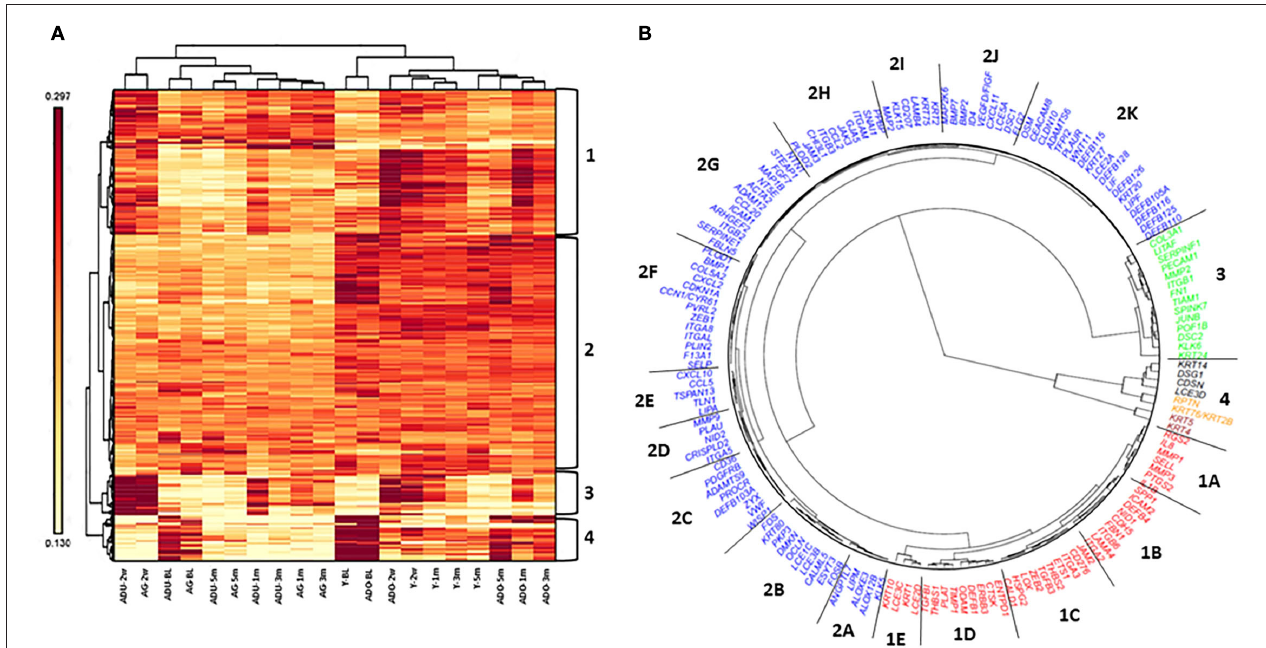
FIGURE 8 | Heatmap and cluster analysis (A) of epithelial-related genes organized by age (Y, ADO, ADU, AG) and health (BL)/disease (2w, 1m, 3m)/resolution (5m) specimens. Numeric identifiers (1–4) provide major clustering of genes that discriminate the samples based upon age and/or disease characteristics of the samples. (B) Fan dendogram of the prominent gene IDs identifying the clusters ( p < 0.01 and/or fold-difference > 1.5/ <